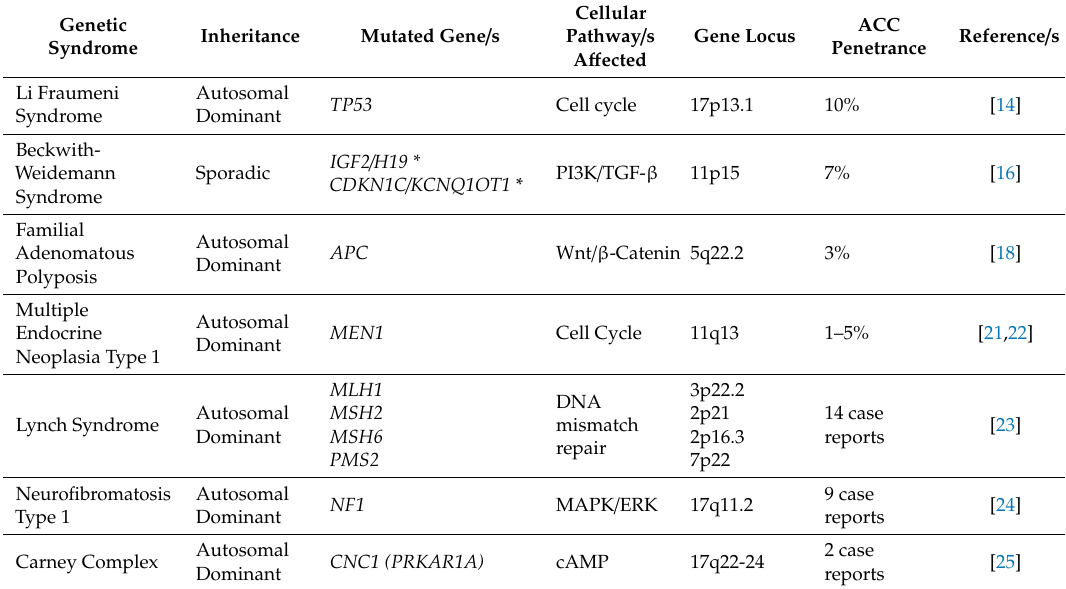
Table 1. Genetic syndromes associated with Adrenocortical